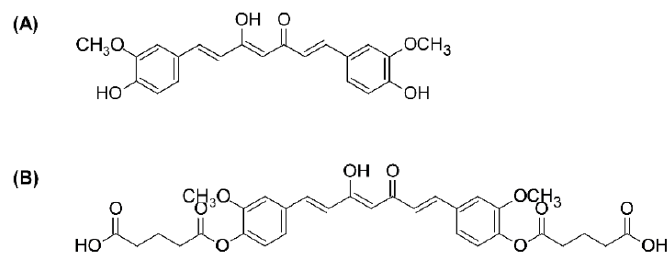
Figure 1. Chemical structures of ( A ) curcumin and ( B ) curcumin diglutaric acid (CurDG) .